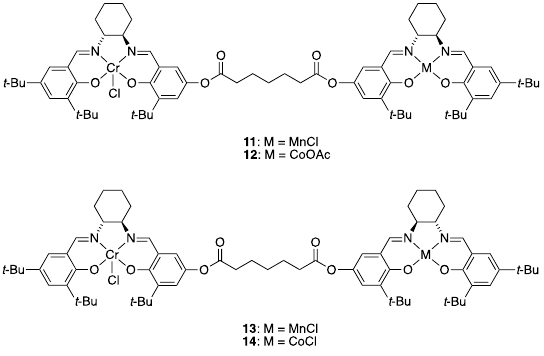
Figure 3. Pseudo- C 2 and pseudo- C s -symmetric heterobimetallic bissalen complexes.